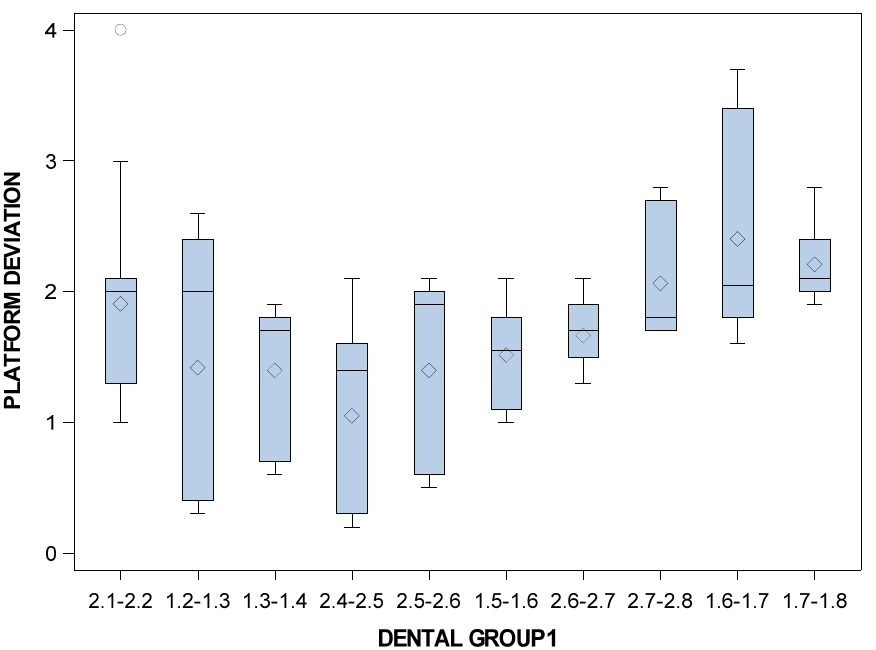
Figure 7. Box plot of the coronal entry-point deviations of the orthodontic micro-screws in the selected tooth positioning.